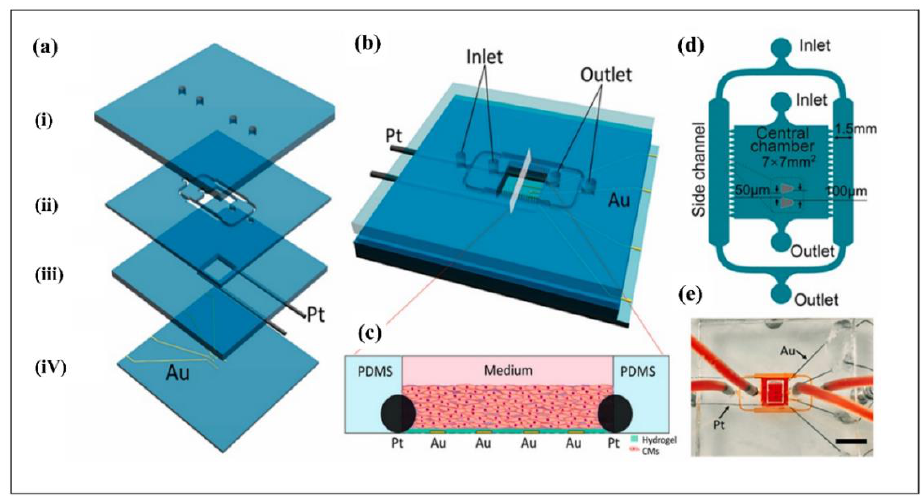
Figure 16. Schematic of heart‑on‑a‑chip device presented by Zhang et al. to investigate in situ elec‑ trical stimulation and observation of the function parameters of cardiac tissues. ( a ) Design of the developed heart‑on‑a‑chip platform consisting of four layers: ( i ) top layer—a PDMS cover layer con‑ taining 4 inlet/outlet channel; ( ii ) a PDMS channel layer; ( iii ) a PDMS chamber layer inserted with two platinum wire electrodes; and the ( iv ) bottom layer—a glass layer coated by four gold electrodes. ( b ) Three‑dimensional illustration of the heart‑on‑a‑chip platform. ( c ) The side view of the schematic demonstrates cardiac tissue in the chamber. ( d ) Magnified sketching of the elaborated design of the PDMS channel, representing the channel layer (ii) in ( a ). ( e ) Picture of the introduced heart‑on‑a‑chip platform. Reprinted with permission from ref. [386], Copyright 2021,